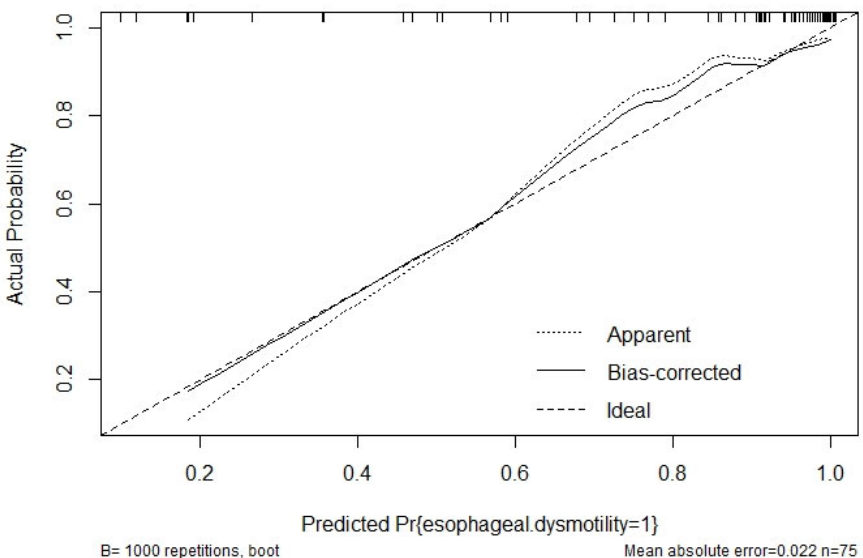
Figure 5. The calibration curve of the diagnostic model. The diagonal dotted line represents perfect prediction by an ideal model; the solid, dashed line represents the performance of the diagnostic model during internal validation by bootstrapping (B = 1000 repetitions).